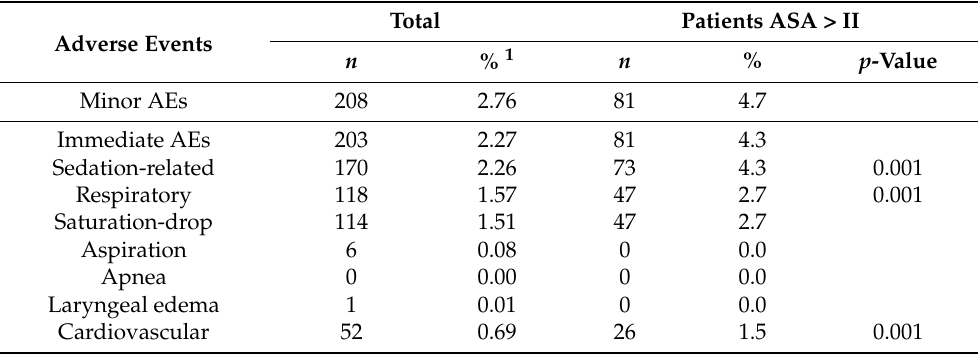
Table 3. Adverse events of all endoscopic procedures, proportion of patients with ASA > II, and significant differences (univariate